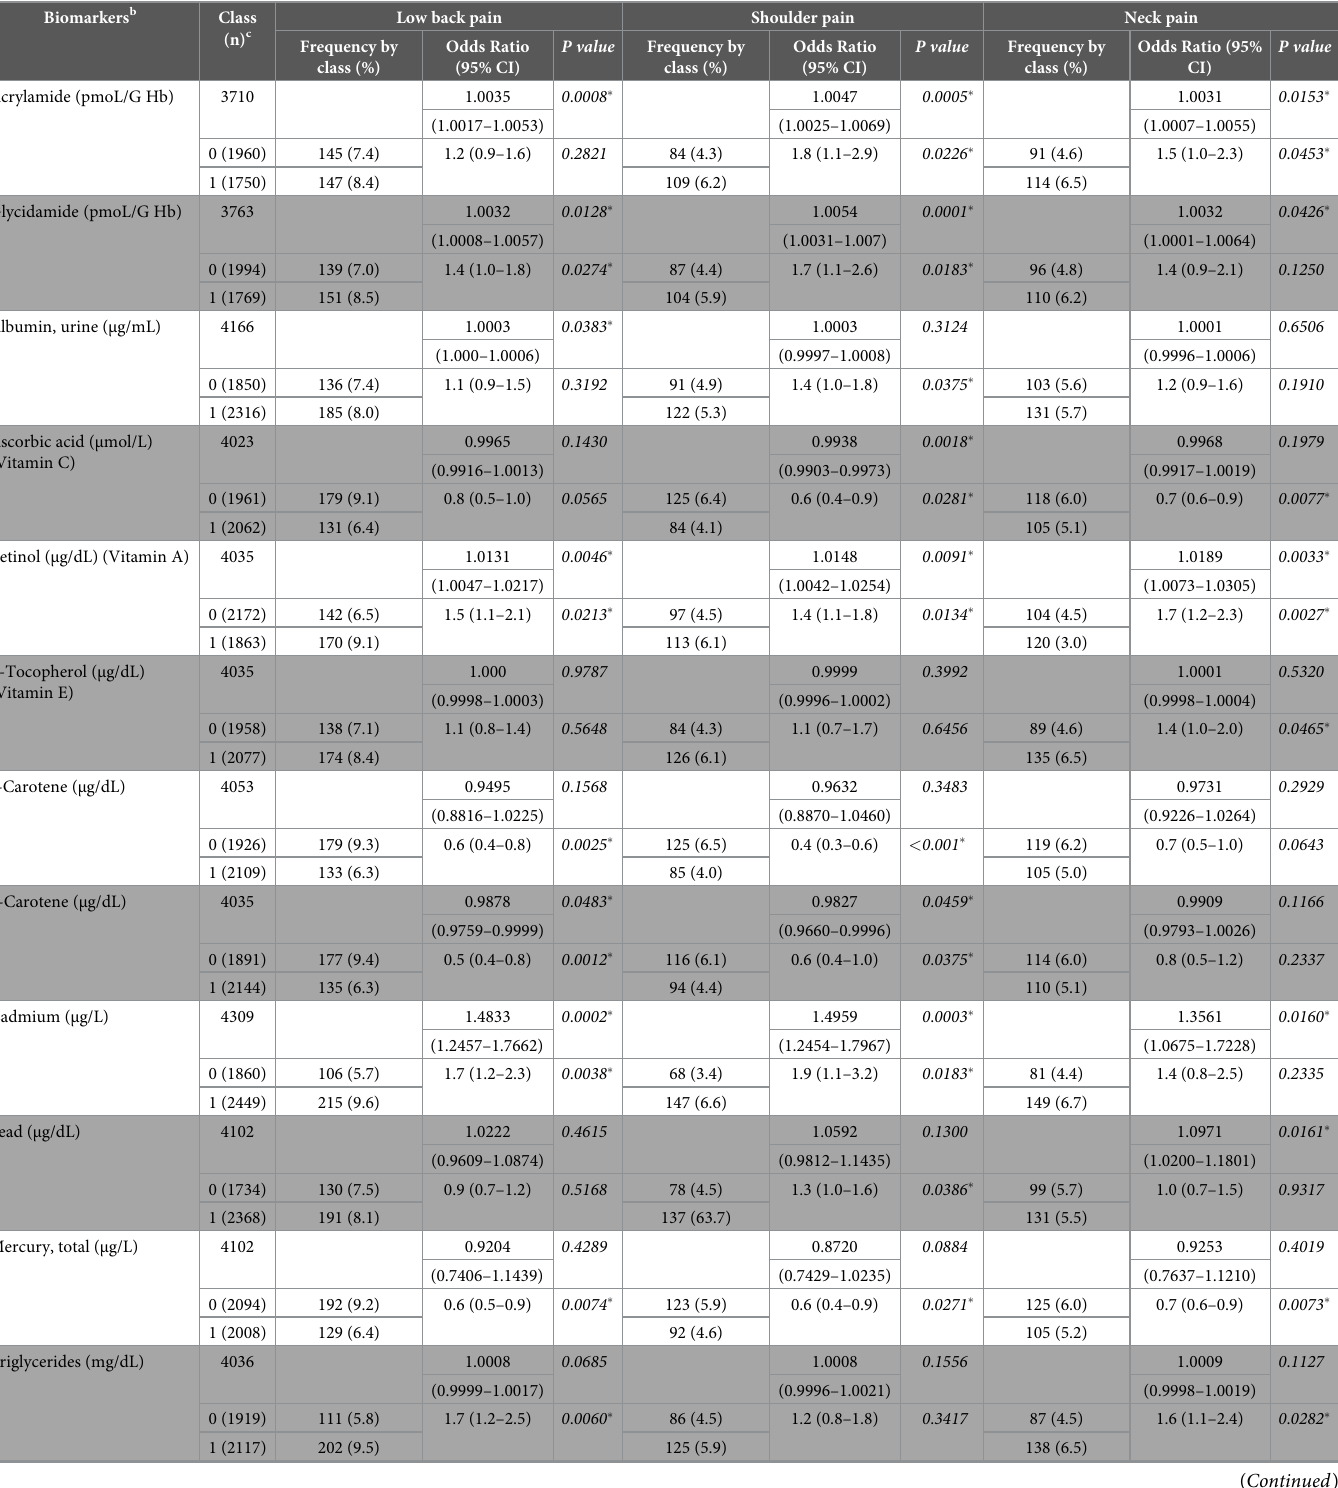
Table 3. Results of multivariable analyses of the associations between biomarkers retained and the three chronic pain a sites. studied (n =